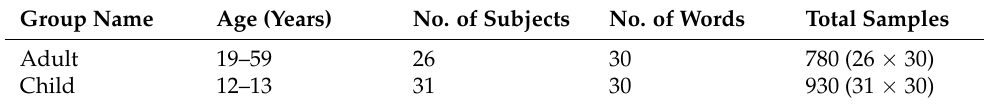
Table 1. Summary of the handwritten text